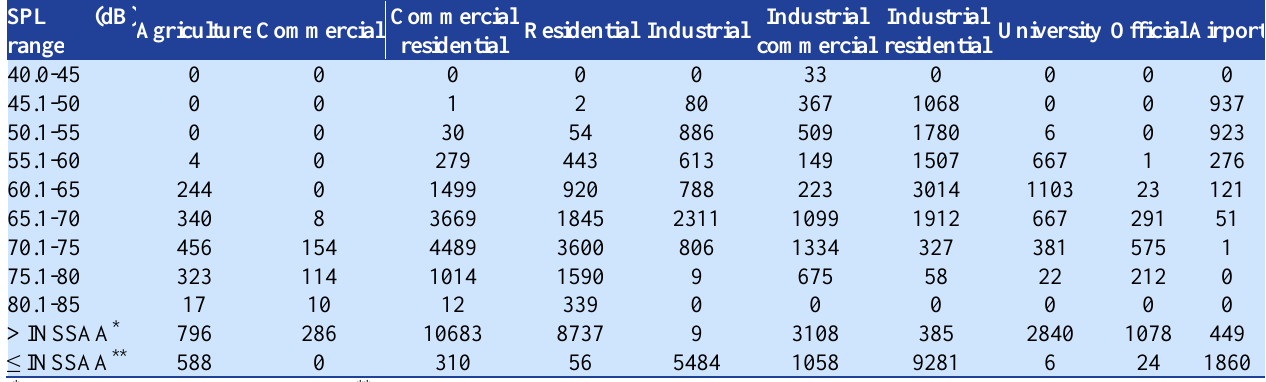
* Total zone area exceeding INSSAA; ** Total zone area not exceeding INSSAA; SPL: Sound pressure level; INSSAA: Iran National Sound Standard at Ambient